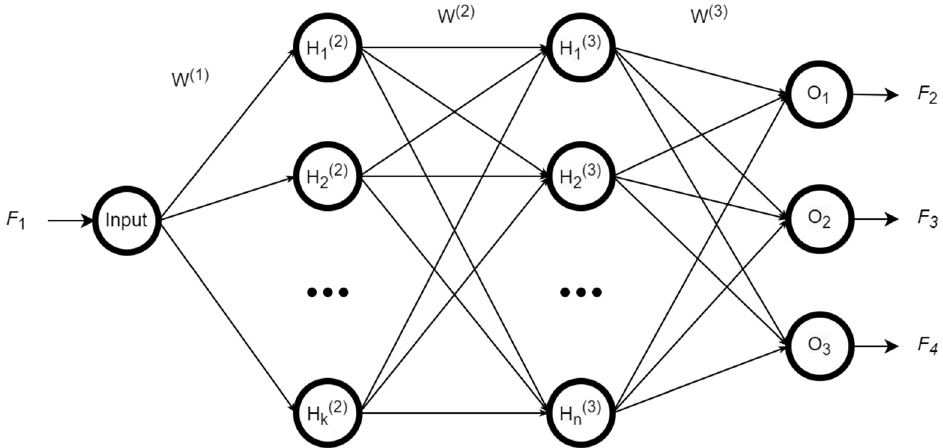
Figure 4. The proposed IN neural network